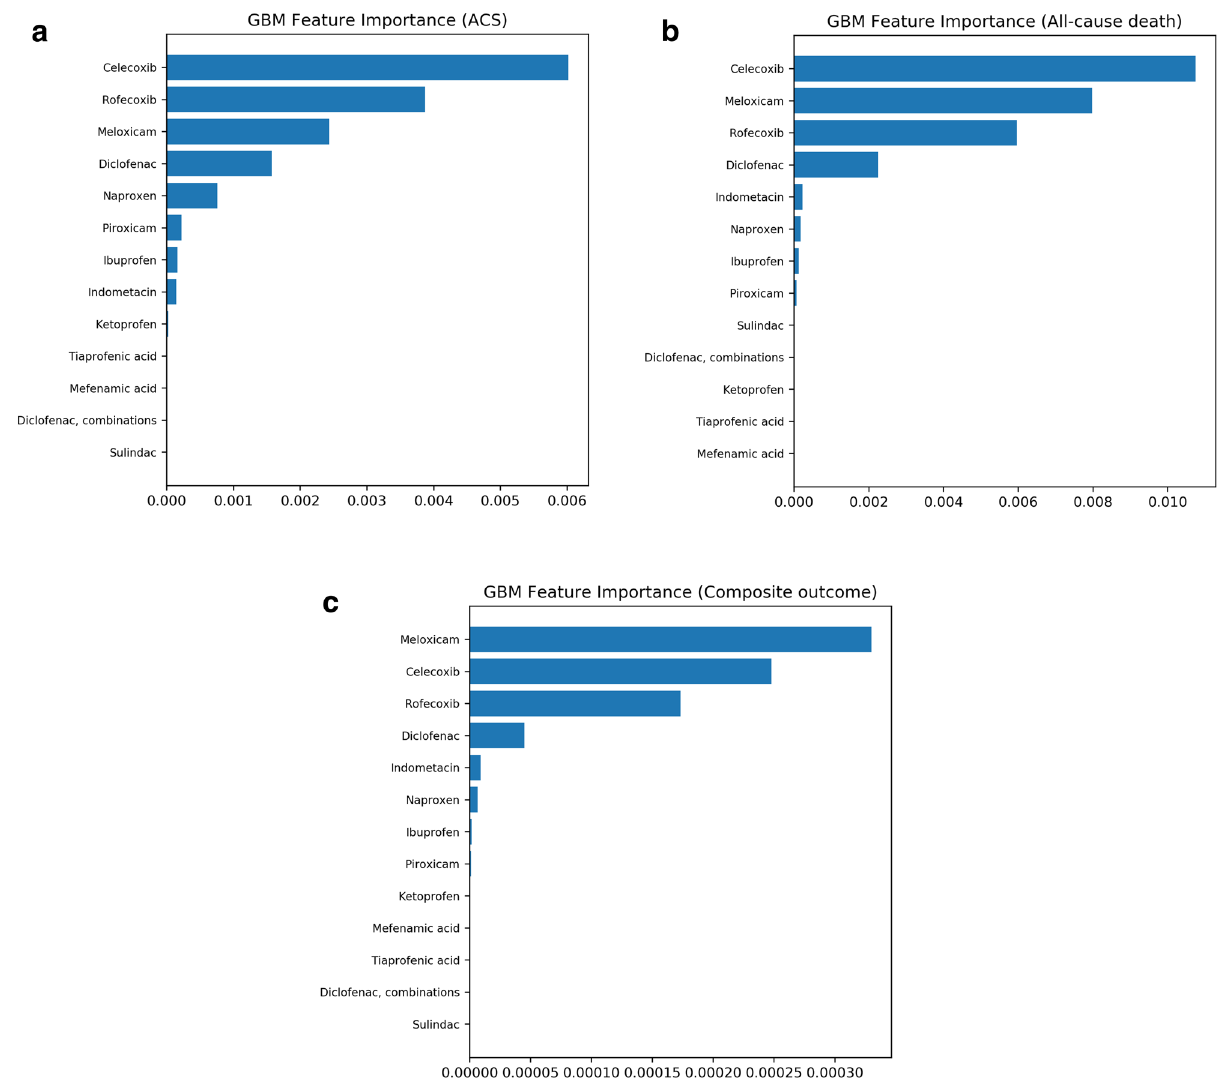
Figure 4. Ranking of NSAID feature importance from the GBM prediction models for adverse cardiovascular outcomes controlling for age, sex, comorbidity history and drug history. ( a ) Feature importance for ACS; ( b ) Feature importance for all-cause death; ( c ) Feature importance for the composite outcome (ACS or all-cause death). The figure was created using scikit-learn 26